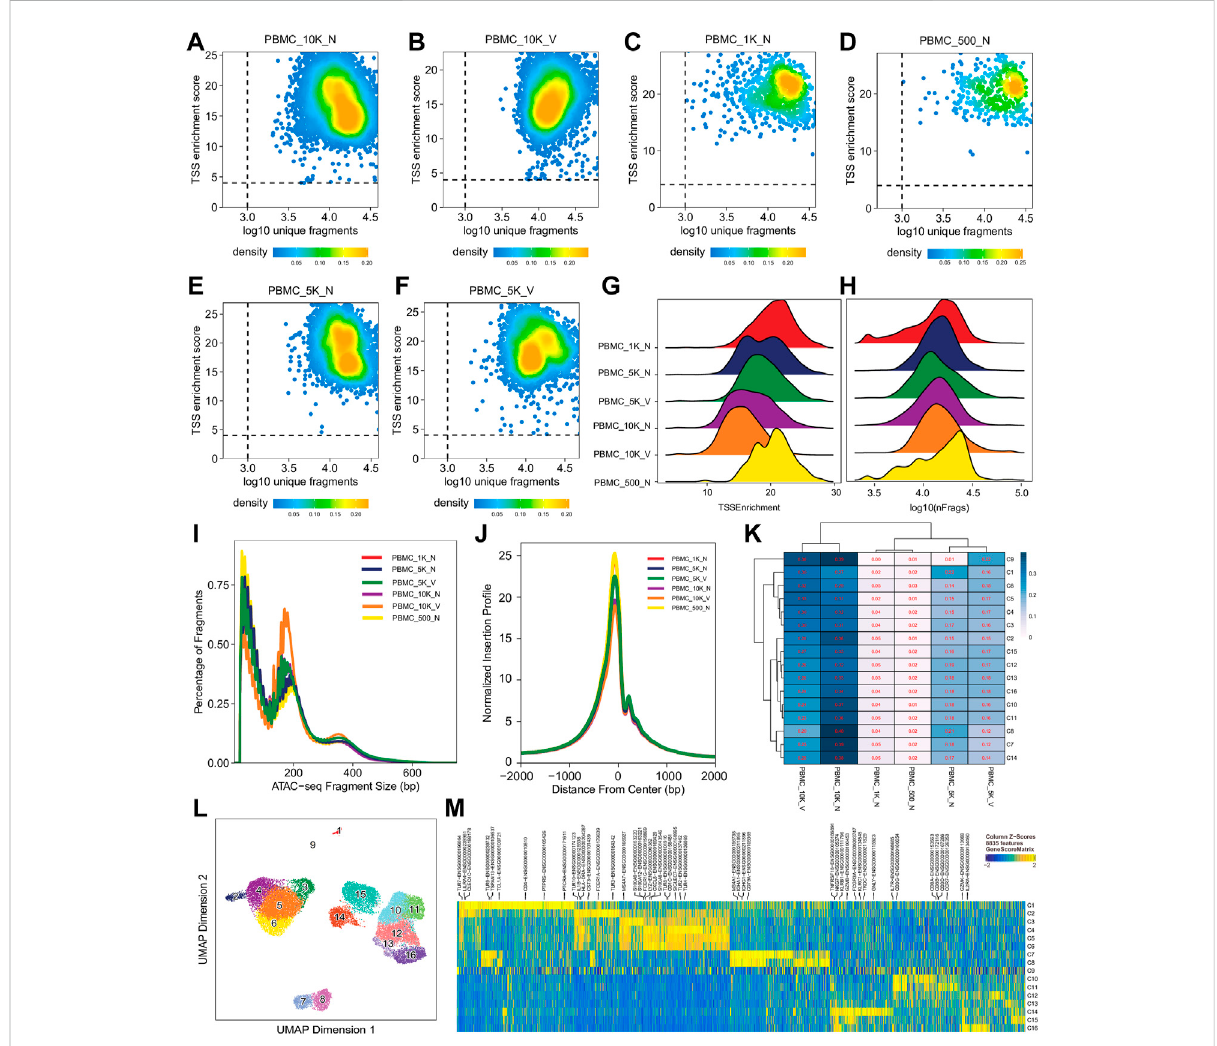
FIGURE 2 Cell- and library-level QC of the human PBMC scATAC-seq data. Fragment fi les were generated for the six samples (outliers excluded) by the default preprocessing sub-work fl ow, and analyzed by the common ArchR-based downstream analysis sub-work fl ow. (A – F) Scatter plots showing bivariate distributions of TSS enrichment scores and log 10 (unique fragments) of individual cells in each of the six libraries. (G,H) Ridge plots showing distributions of TSS enrichment scores and log 10 (unique fragments) of individual cells per library, respectively. (I) Density plots showing insert size distributions per library. (J) Normalized insertion pro fi lesalong ±2-kb regions fl anking TSSs. (K) Clusteredheatmap showing proportions of cells per cluster from each library, with each row summing up to 1. (L) UMAP plot showing 16 clusters identi fi ed from the scATAC-seq data. (M) Heatmap showing cluster-speci fi c marker genes across 16 clusters. Noticeably, cluster C9 has a noisy, weak pattern of marker genes, which suggests that it is very likely formed by